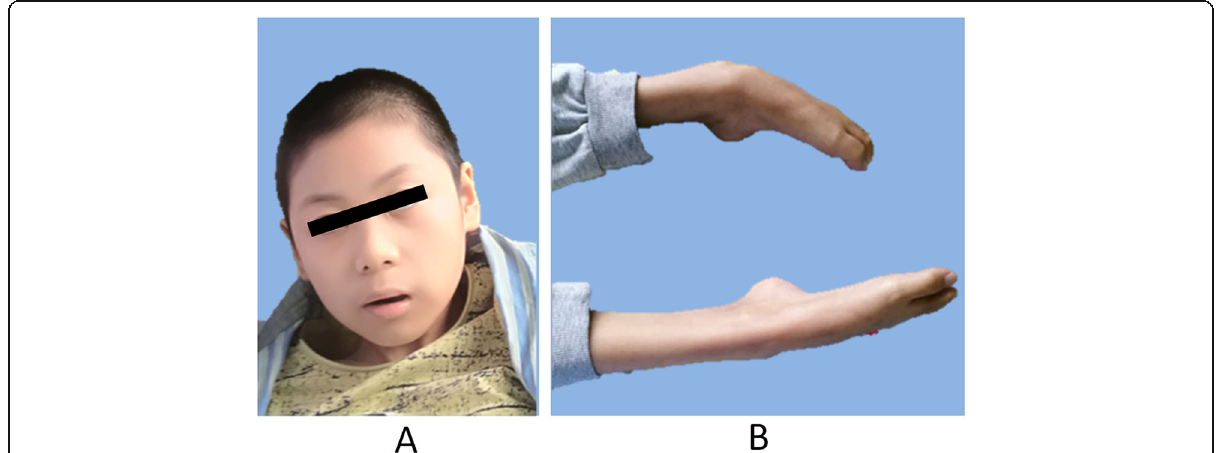
table (Additional file 1: Table S1). This deletion can be classified as pathogenic and is described as arr.